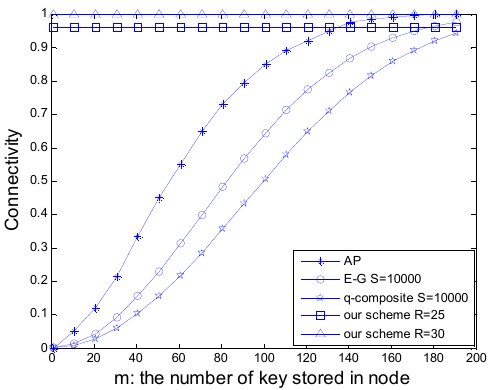
Figure 5. ( a ) The network connectivity when the communication radius R = 30; ( b ) The fitness value when the node communication radius R = 30.